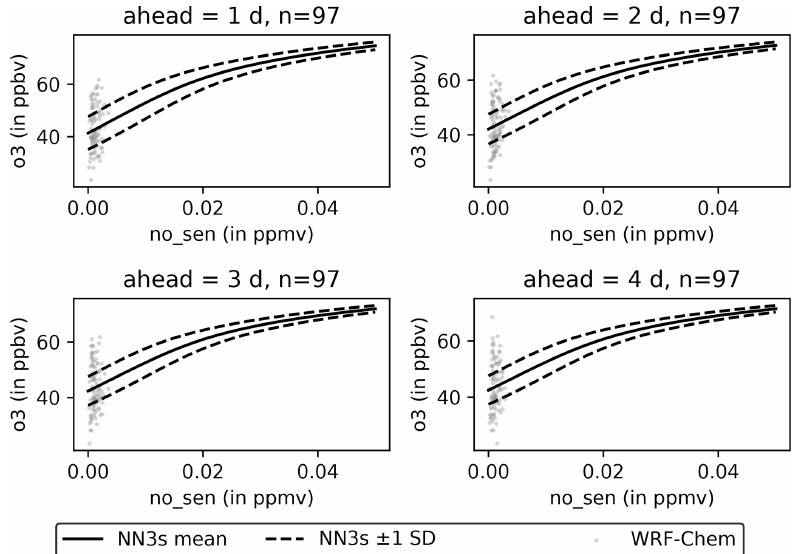
Figure 13. Same as Fig. 11 but for NO instead of ozone